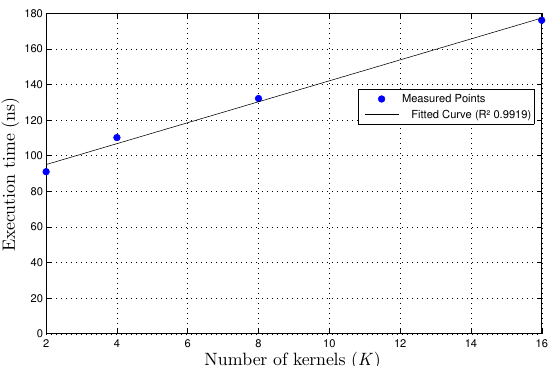
Figure 14. Linear regression curve for execution time per sample for varing numbers of kernels k , Iris dataset floating-point